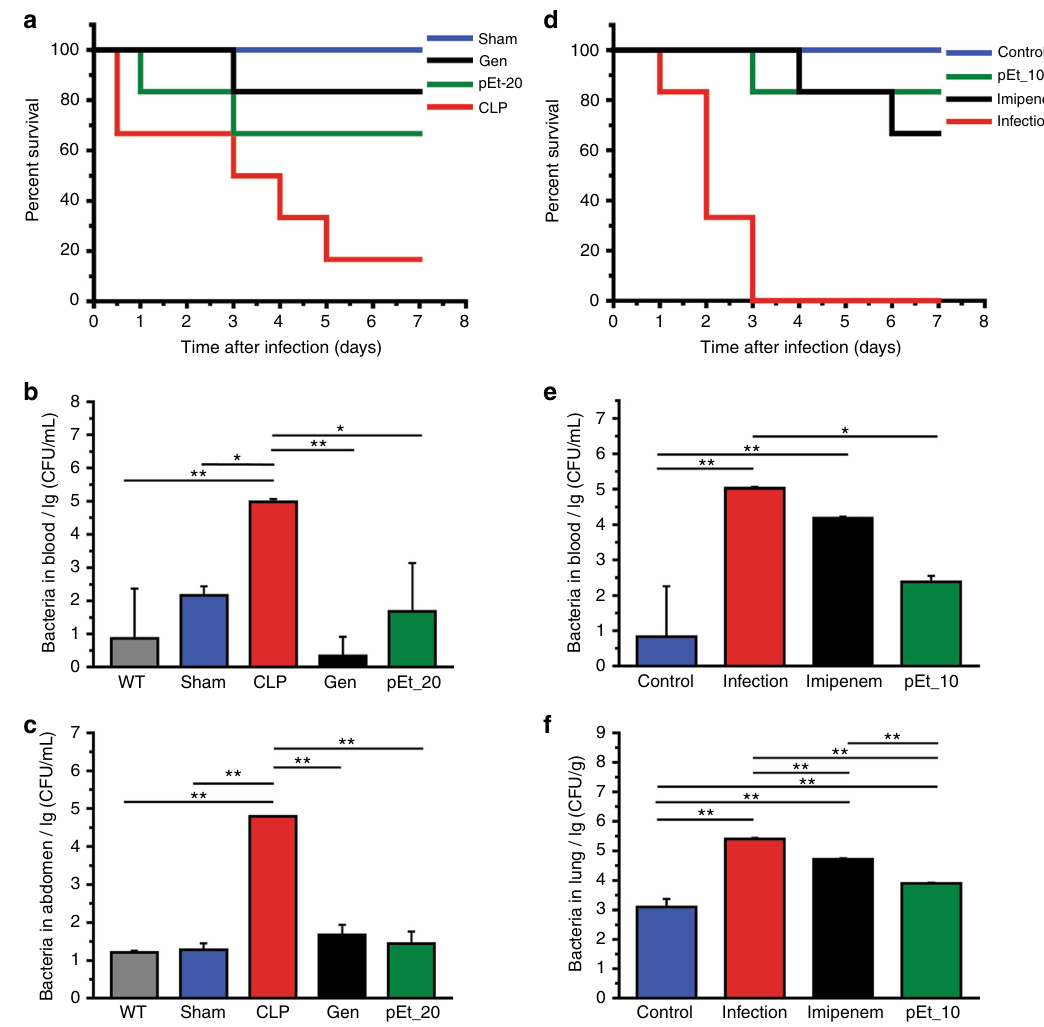
Fig. 7 In vivo ef fi cacy in CLP and P . aeruginosa lung infection models. a – c Cecal ligation and puncture (CLP) model; d – f P . aeruginosa (PA14)-caused lung infection model. a Survival of mice in the sham group that went through surgery but without CLP, in the CLP group without treatment, in the gentamicin- treated CLP group (Gen, 10 mg/kg mouse body weight at 1 h and 6 h post infection), and in the pEt_20-treated group (pEt_20, 25 mg/kg mouse body weight at 1 h and 6 h post infection; each dose lower than LD 5 value) ( n = 6, p = 0.0112 (<0.05), Log-rank test). b Microbial counts (CFUs) in the blood